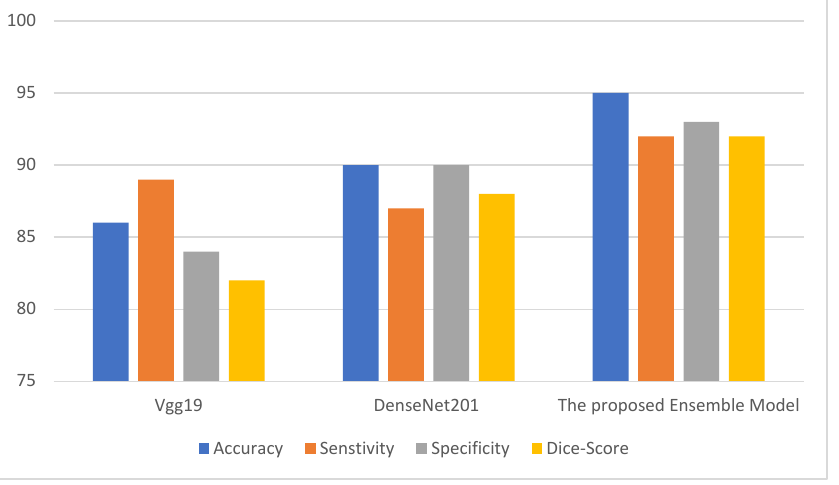
Figure 3. The performance of Vgg19, DenseNet201, and the ensemble models for the BIG-D15 database.